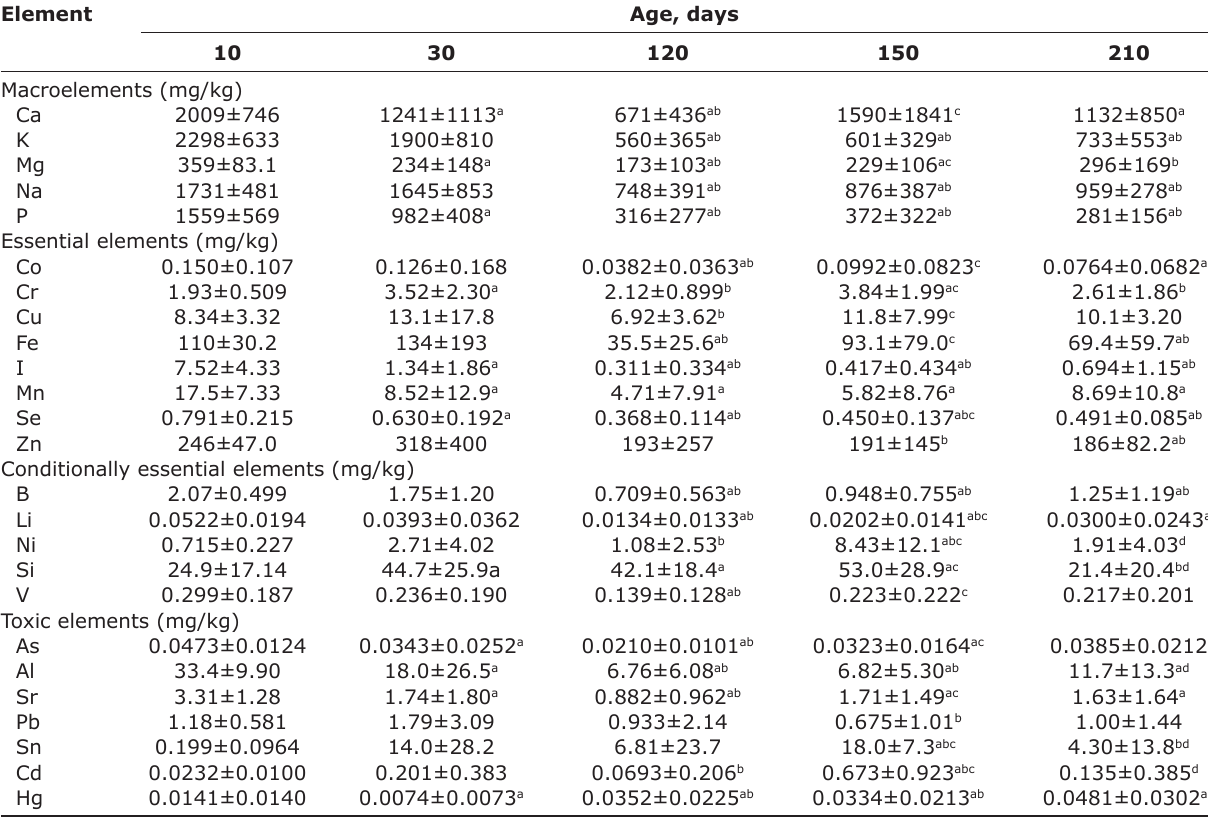
Table-2: The concentration of main essential and toxic elements in laying hens in different periods of ontogenesis.